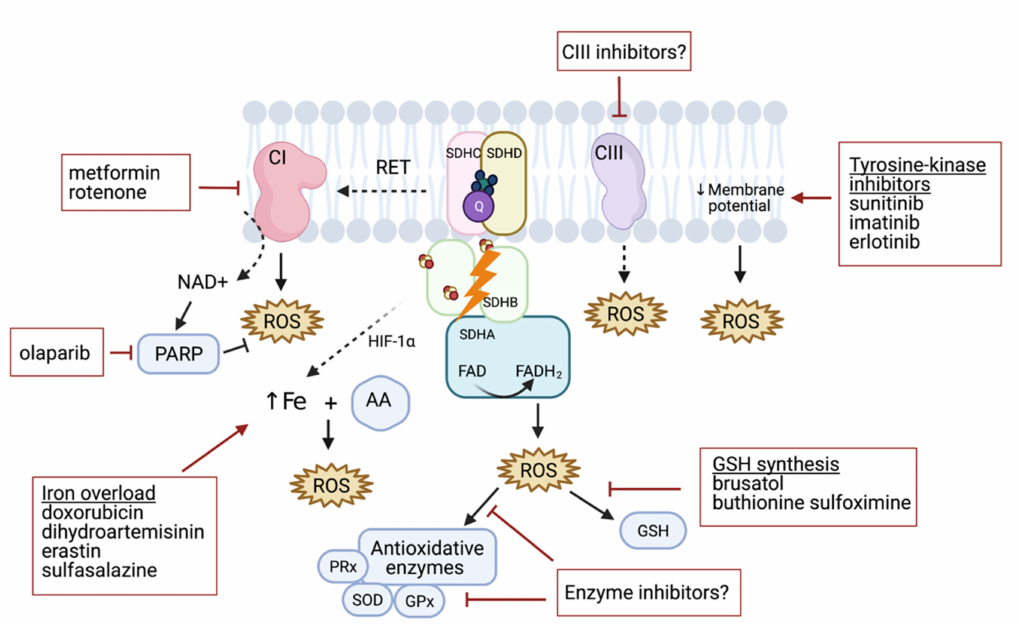
Figure 3. Targeting different mechanisms to induce and enhance ROS production in PHEO/PGL. ROS are generated by mitochondrial complex CI–CIII dysfunction, which may be further supported by CI, CII, and CIII inhibitors. Similarly, decreasing the membrane potential can lead to ROS accumulation. CII-related ROS production can be enhanced by increasing the iron pool and consequently increasing ROS production under ascorbate (AA) treatment. Downregulating glutathione (GSH) synthesis can decrease antioxidant protection with other antioxidative enzyme inhibitors including peroxidases (PRx), superoxide dismutase (SOD), and glutathione peroxidase